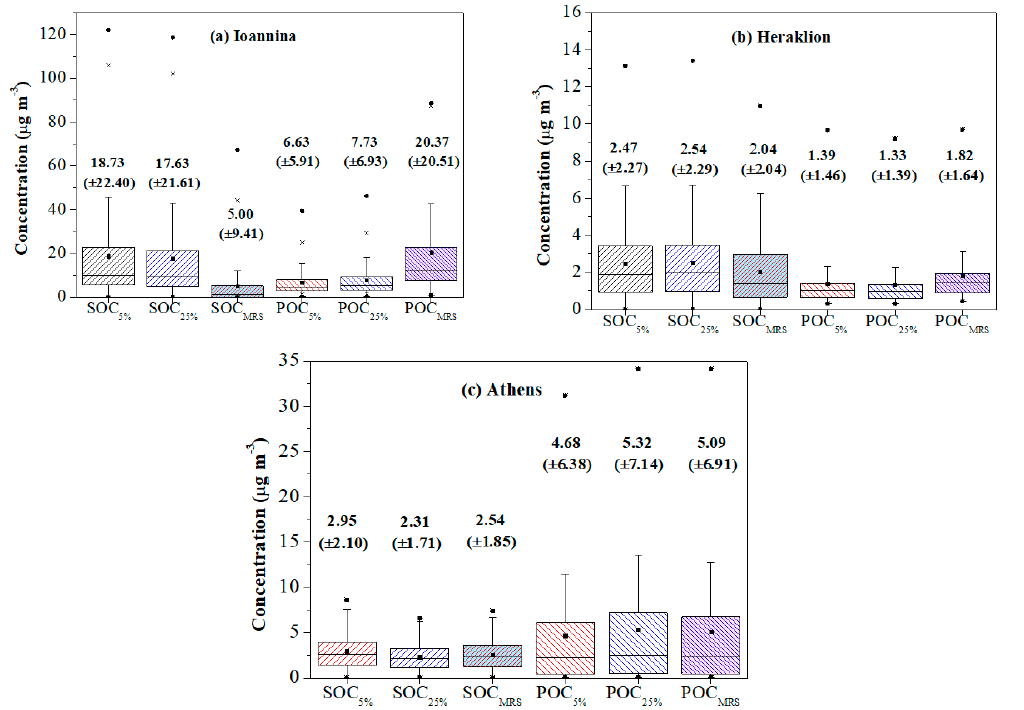
Figure 4. SOC and POC concentrations (box-whisker plots) in Ioannina ( a ), Heraklion ( b ), and Athens ( c ), using the 5% percentile, 25% percentile, and MRS method. Mean values ± 1 standard deviation are also displayed.